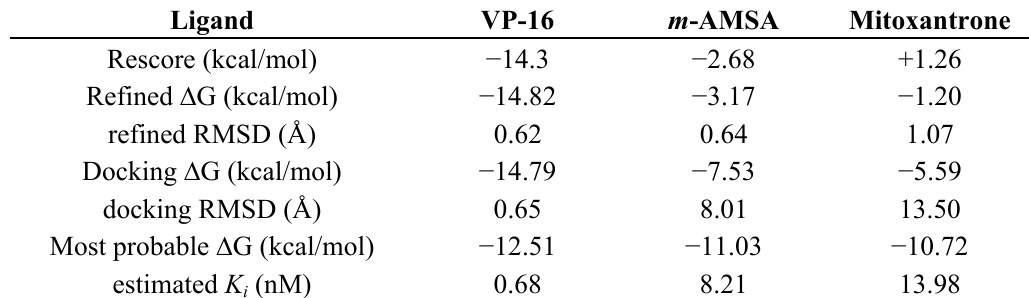
Table 1. Estimated binding free energies of VP-16, m -AMSA and mitoxantrone in the cleavage complex of TOP2- β .